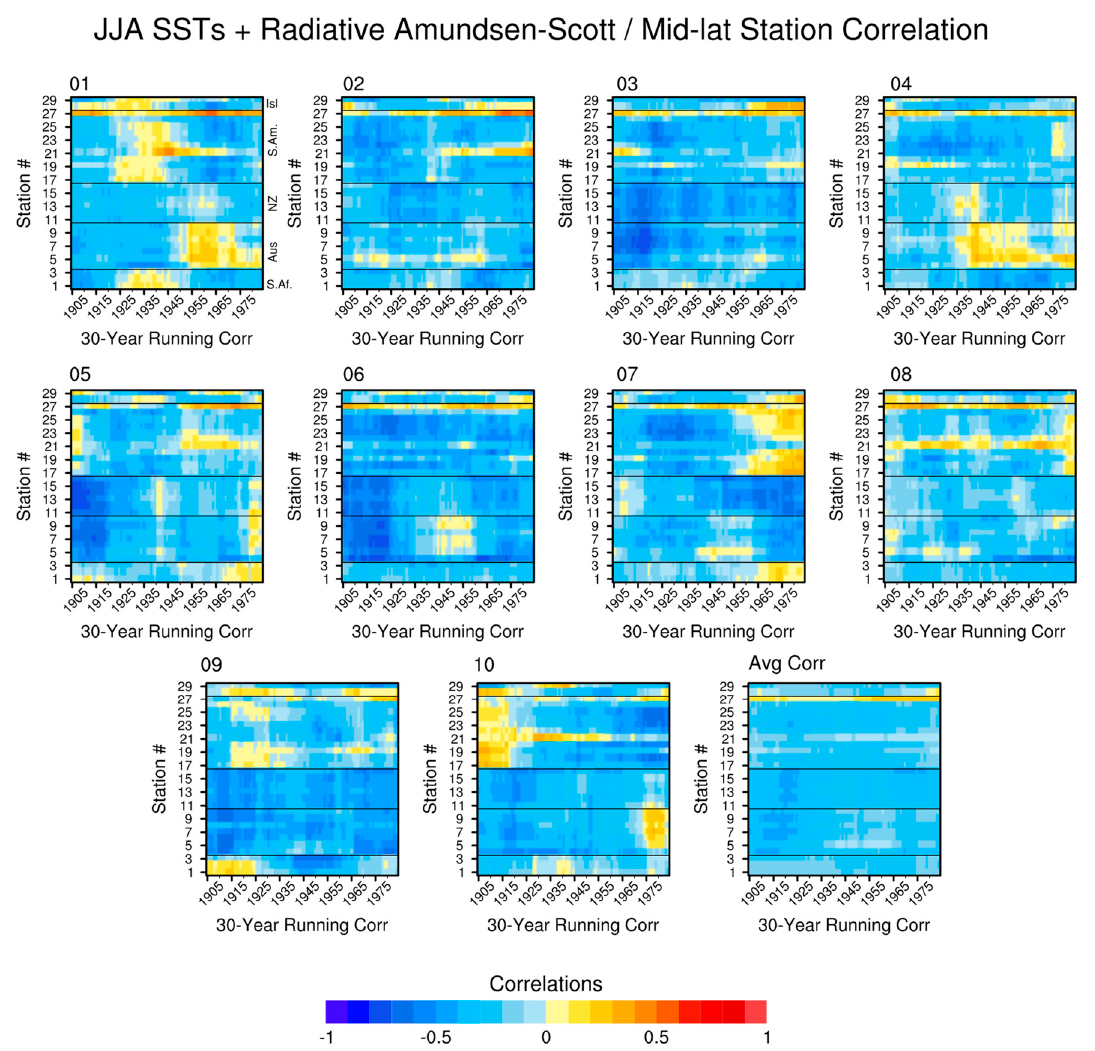
Figure 8. 30-year running correlations across all 29 midlatitude stations to Amundsen-Scott during the austral winter for the SSTs + Radiative CAM5 experiment. Each plot depicts an individual ensemble, along with an average between these ensembles in the bottom right. The stations are grouped by region (labeled on right of first plot), with each number on the y-axis corresponding to the station name listed in Figure 1. The southern midlatitude regions include islands (Isl), South America (S. Am.), New Zealand (NZ), Australia (Aus) and South Africa (S. Af.).